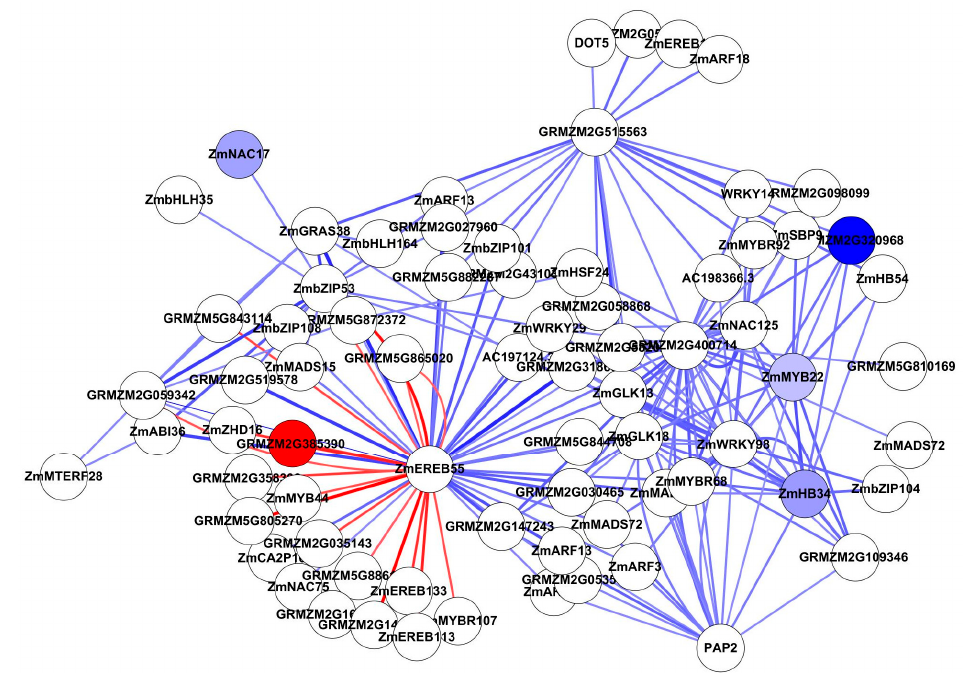
Figure 7. Top 200 interactions from TFs by ANN analysis (Study 2). All nodes are coloured by expression fold change value (FC > 2), blue represents down-regulated, while red represents up-regulated. Edge with red colour indicates a positive interaction (stimulation), while edge with blue colour indicates a negative interaction (inhibition). The edge thickness based on Z- score value.